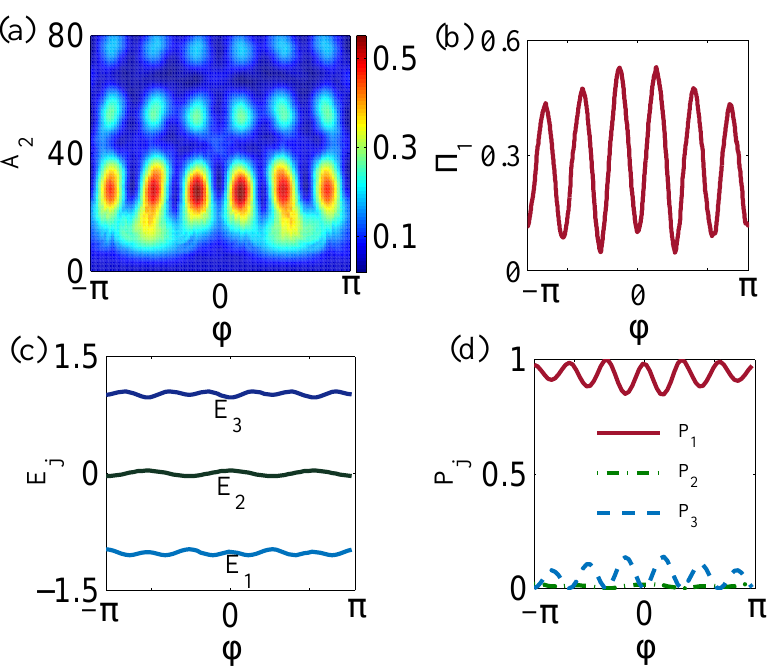
Figure 7. (Color online) ( a ) Evolution of Π 1 as a function of φ and A 2 for A 1 = 24. ( b – d ) Tunneling probability Π 1 , quasienergies and localized dark Floquet states versus the phase difference φ varying from − π to π . Other parameters are the same as in Figure